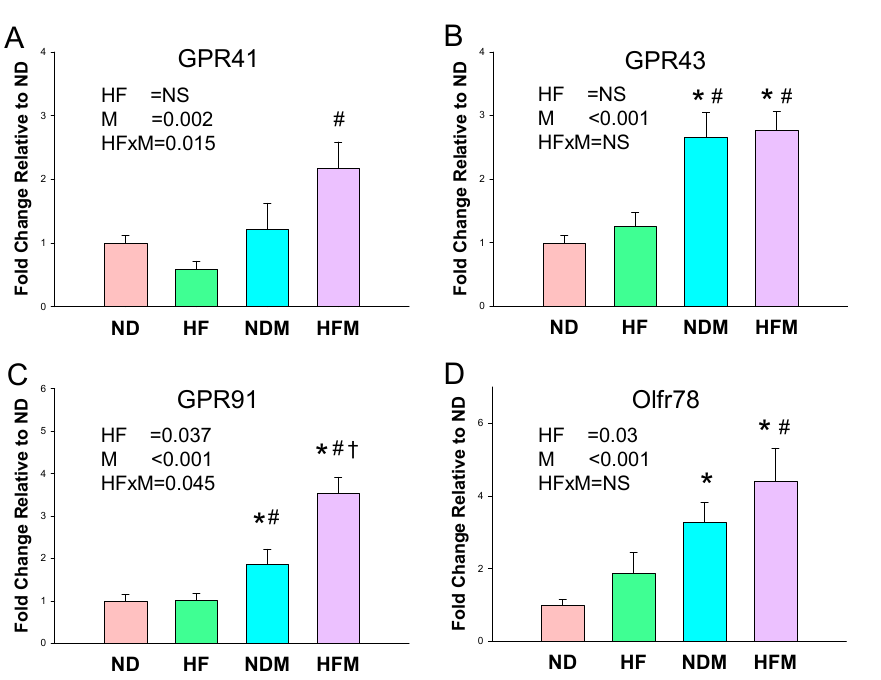
Figure 2. Effect of high-fructose diet (HF) and minocycline administration (M) on short chain fatty acid (SCFA) receptors in offspring kidneys. The mRNA expression of SCFA receptor ( A ) G protein-coupled receptor 41 (GPR41), ( B ) GPR43, ( C ) GPR91, and ( D ) olfactory receptor 78 (Oflr78); HF × M = the interaction between high-fructose diet and minocycline. NS = not significant; HF × M = the interaction between high-fructose diet and minocycline. * p < 0.05 vs. ND; # p < 0.05 vs. HF; † p < 0.05 vs.